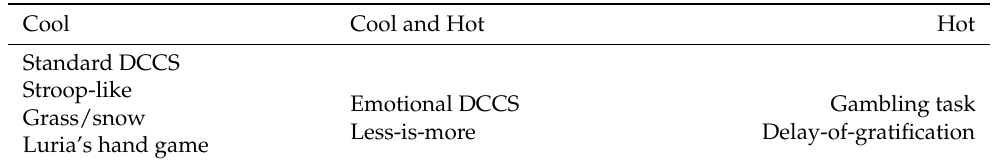
Table 1. Classification of cool and hot EF